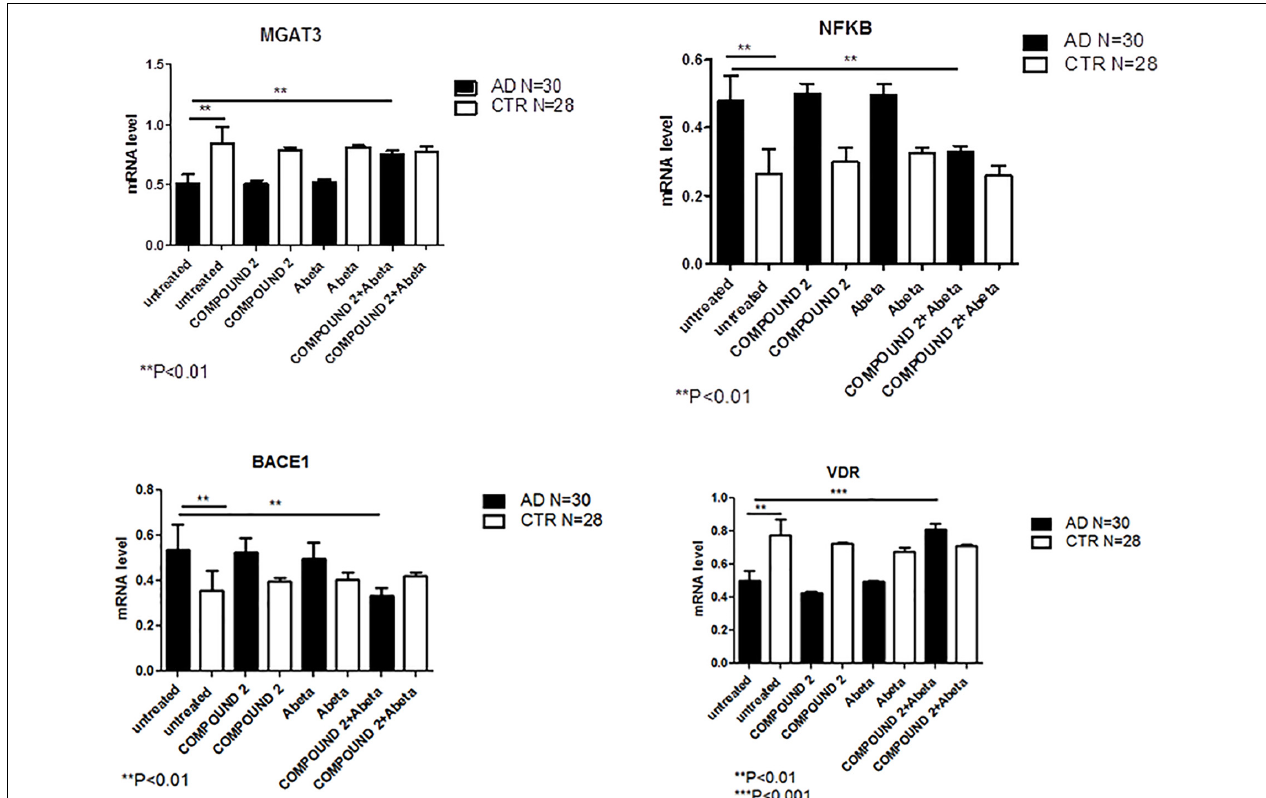
FIGURE 8 | MGAT3 , NF- κ B , BACE1 , and VDR gene expression in PBMCs from AD patients and control subjects treated with A β (48 h) or untreated, and COMPOUND 2 (24 h) or COMPOUND 2 (24 h) + A β (24 h).